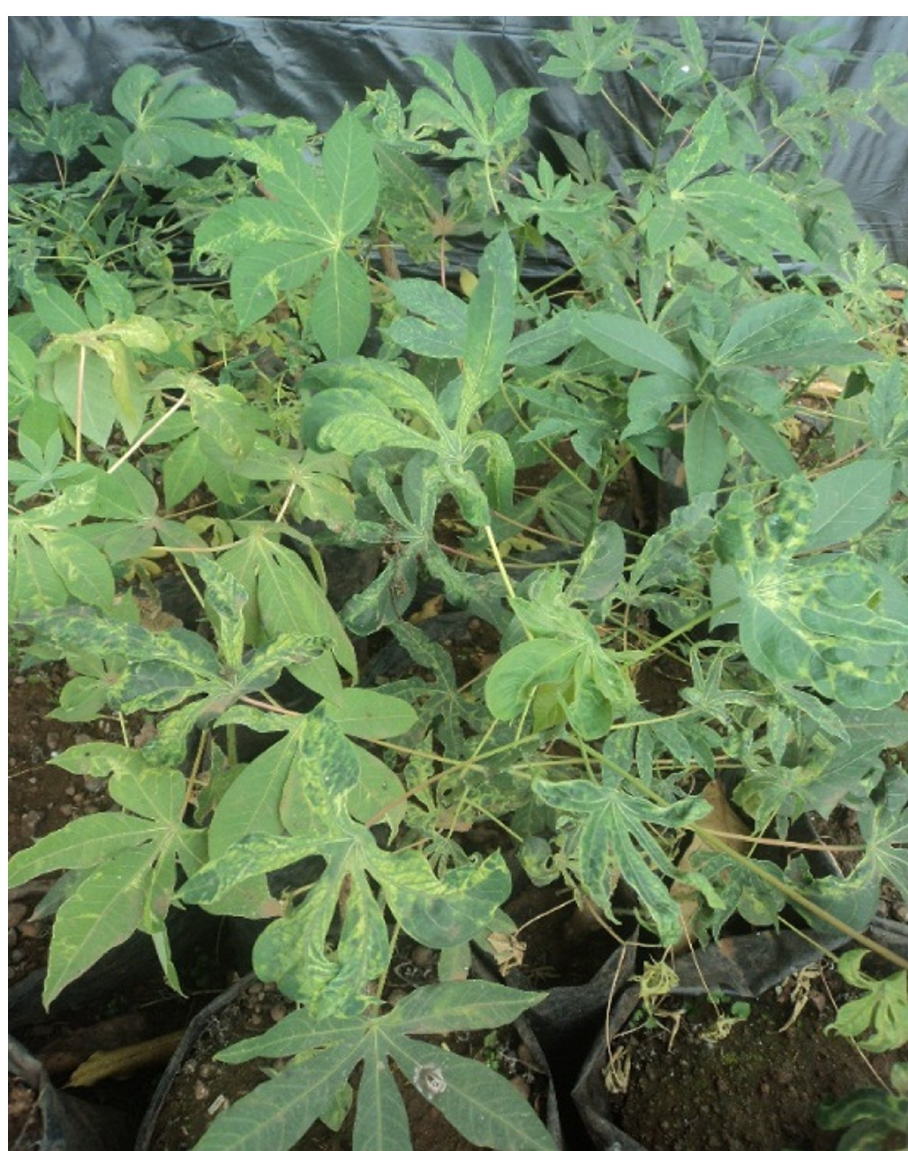
Fig 1. Cassava plants infected with cassava mosaic geminiviruses used as